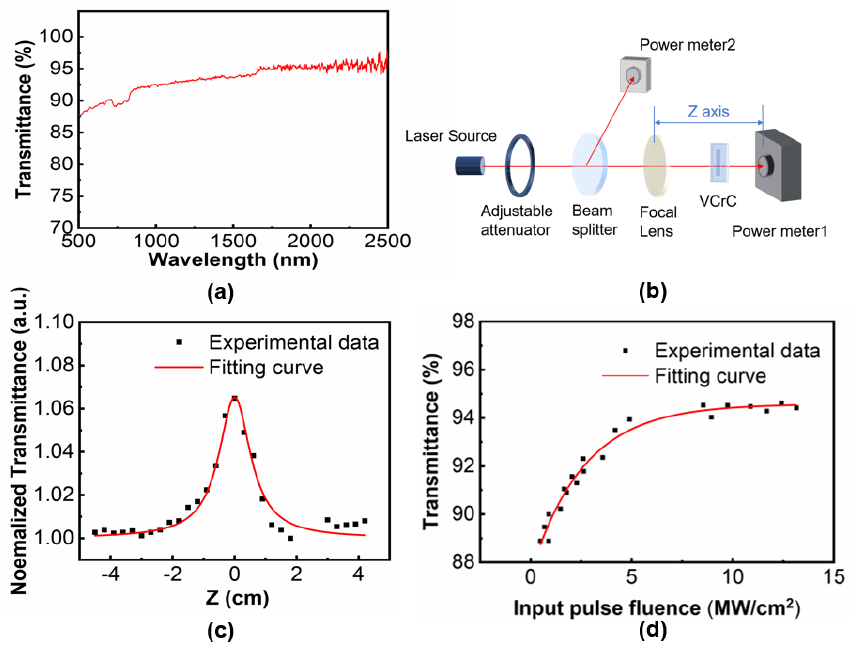
Figure 2. ( a ) Linear optical transmittance spectrum of the MXene VCrC SA. ( b ) Schematic diagram of the open-aperture (OA) Z-scan. ( c ) OA Z-scan curve and ( d ) nonlinear transmittance curve.